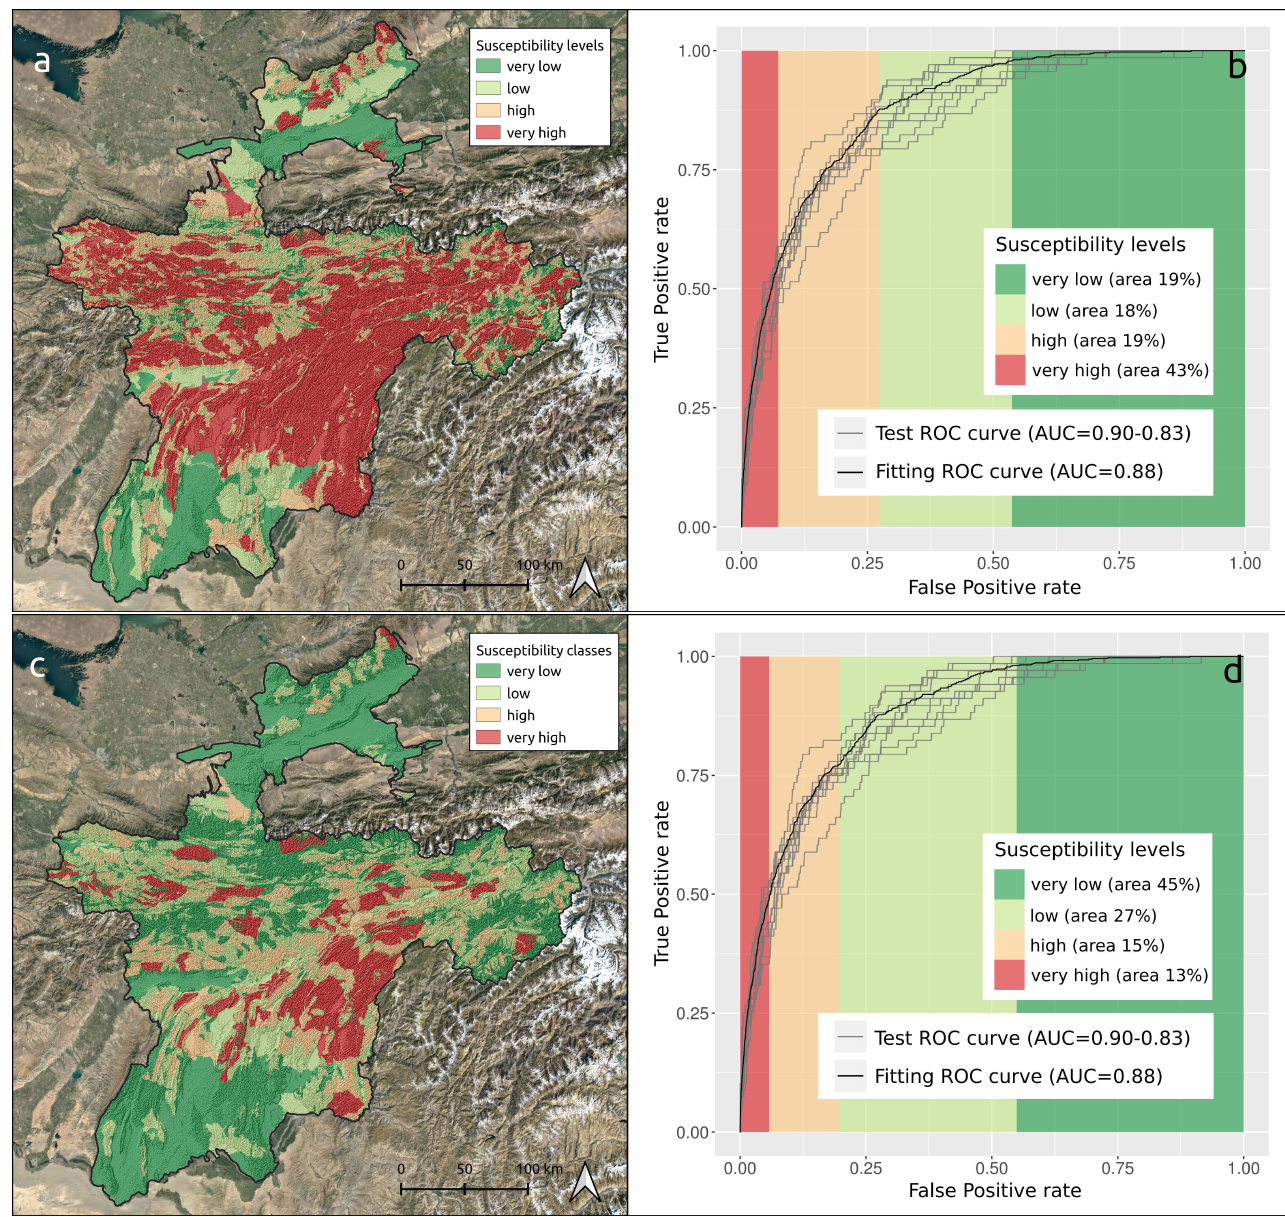
Figure 6. ( a ) Tajikistan landslide susceptibility map classified by maximizing the AUC and the relative ROC curves with respect to the unstable UCUs. ( c ) Tajikistan landslide susceptibility map classified by maximizing the AUC of the area- weighted ROC curve and the relative ROC curves. Panels ( b , d ) show the corresponding classification schemes and the relative percentage area per